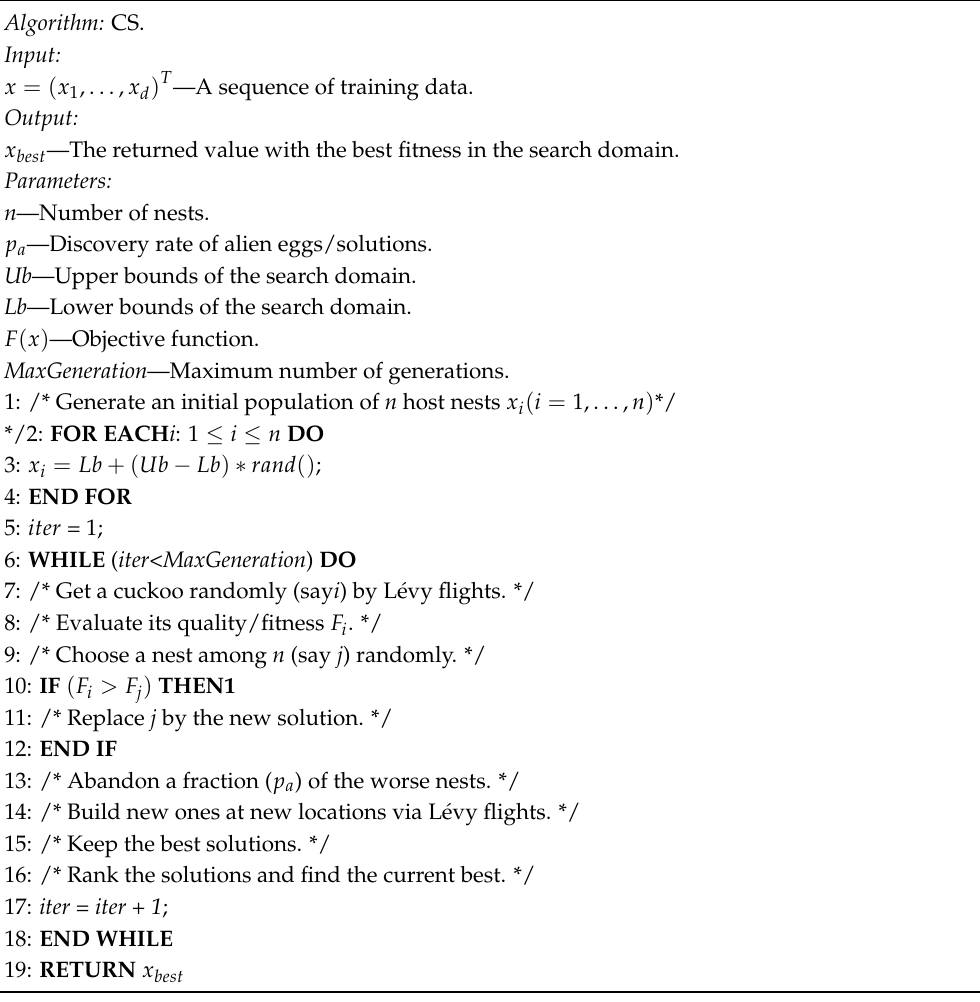
Algorithm A1 The shortened process of the cuckoo search algorithm. Algorithm: